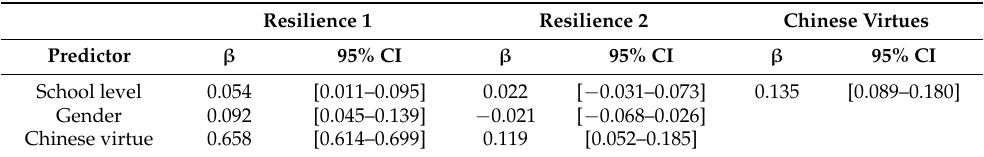
Table 4. Standardized Coefficients and 95% Confidence Intervals for SEM model of Resilience and Chinese Virtues (bootstrap =